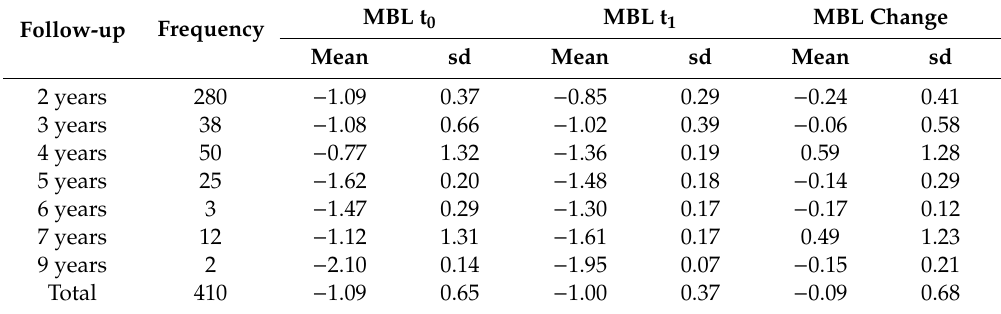
Table 4. Mean marginal bone level (MBL) (mm) at implant insertion (t 0 ) and at last follow-up visit (t 1 ) and mean MBL change (mm) divided by time of follow-up. sd: Standard Deviation.